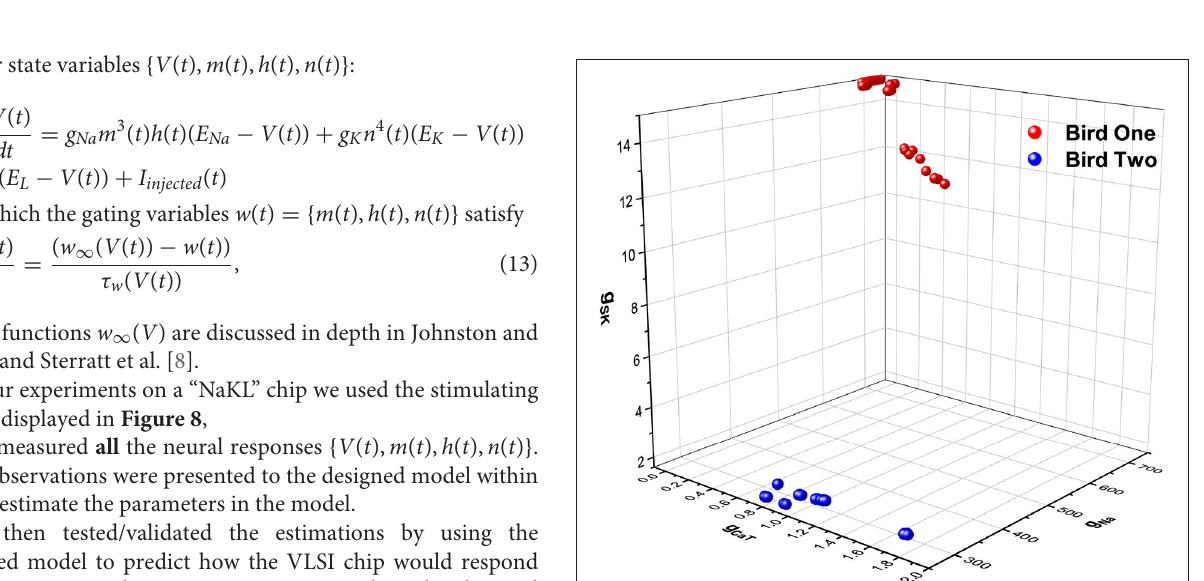
FIGURE 6 | (A) One of the library of stimuli used in exciting voltage response activity in an HVC X neuron. The cell was prepared in vitro , and a single patch clamp electrode injected I injected ( t ) (this waveform) and recorded the membrane potential. (B) The voltage response. One of the library of stimuli used in exciting voltage response activity in an HVC X neuron. The cell was prepared in vitro , and a single patch clamp electrode injected I injected ( t ) (this waveform) and recorded the membrane potential.